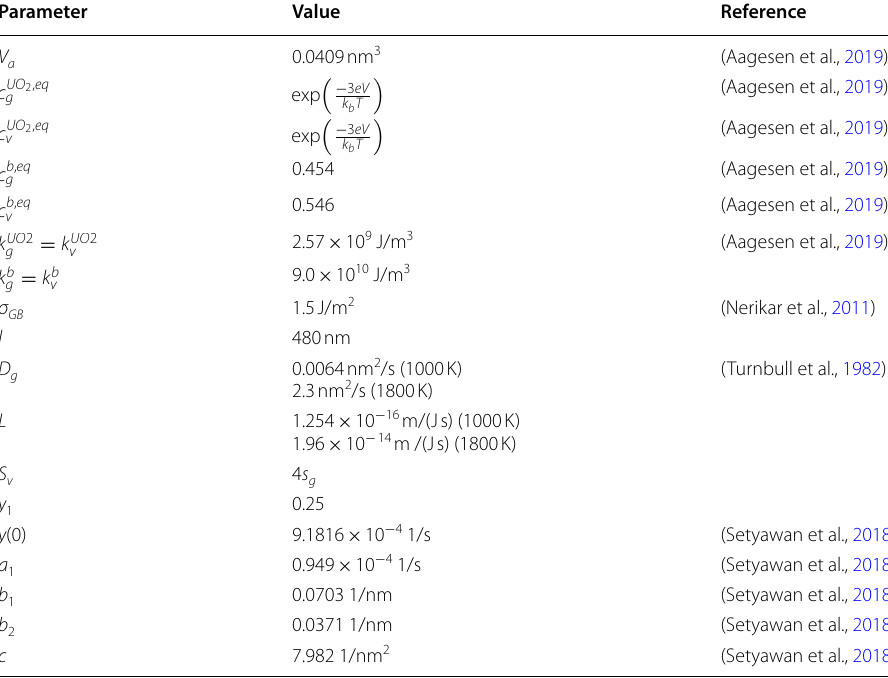
Table 1 Parameters used in the MARMOT simulations, including the reference citation(s)